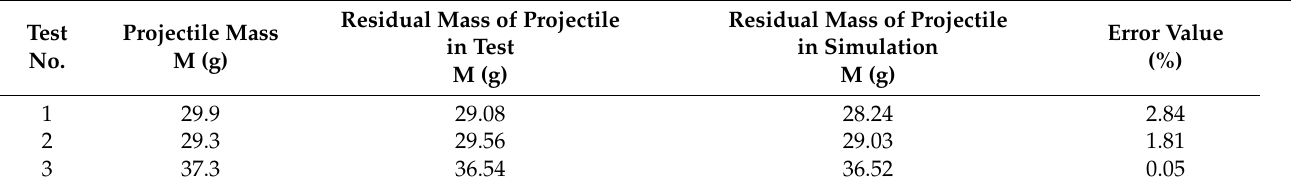
Table 5. Comparison between experimental and calculated residual mass of the